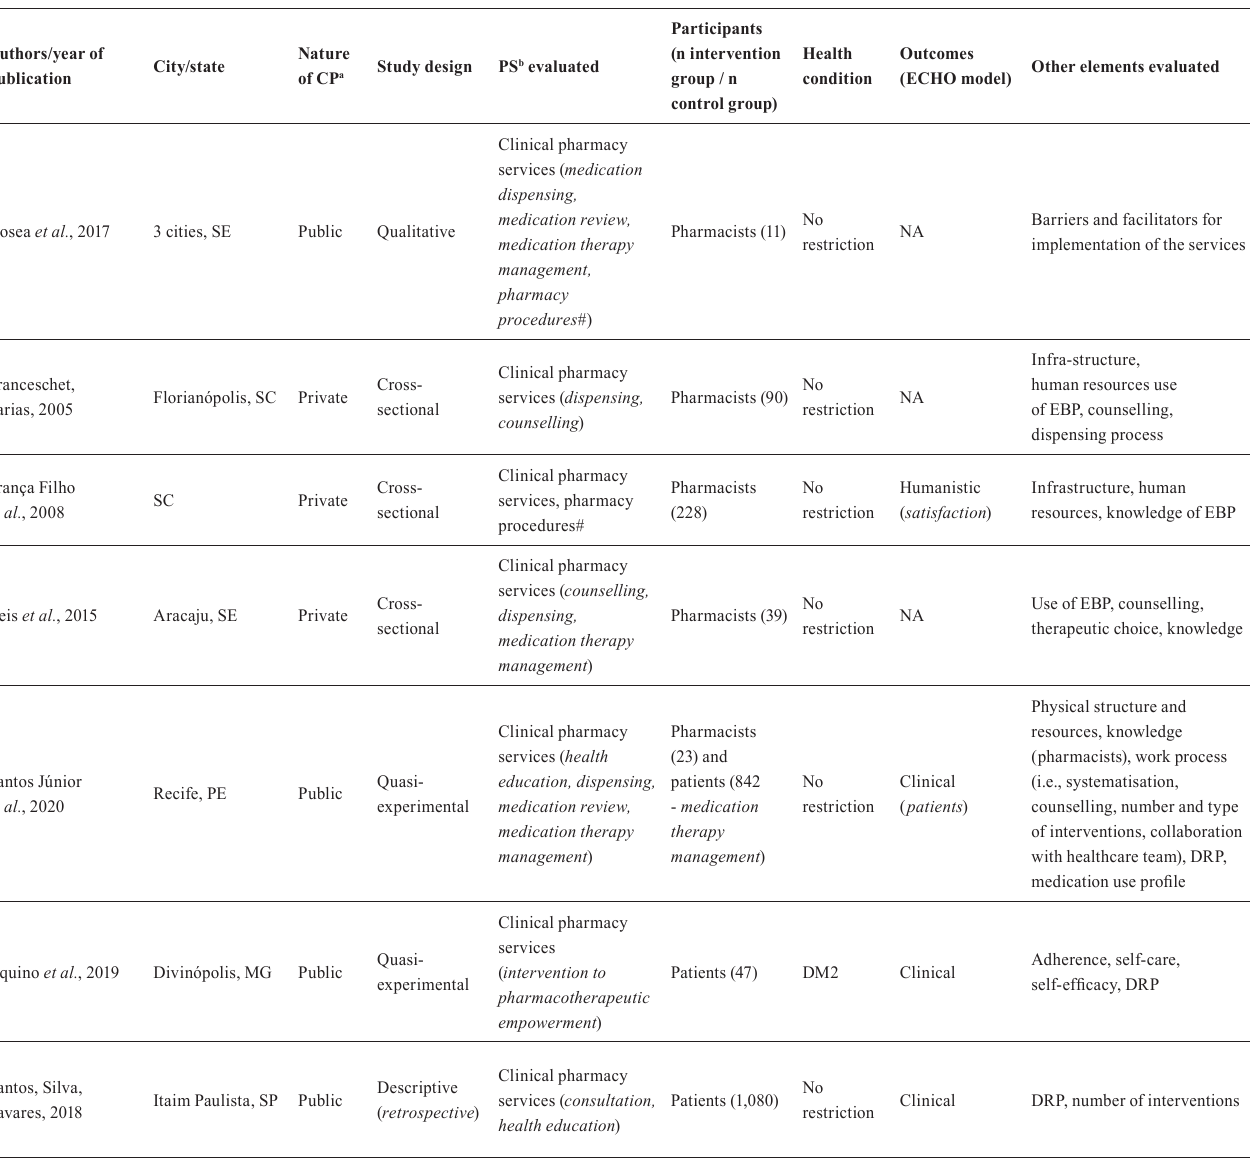
TABLE I - S ummary of the data from studies included in the scoping